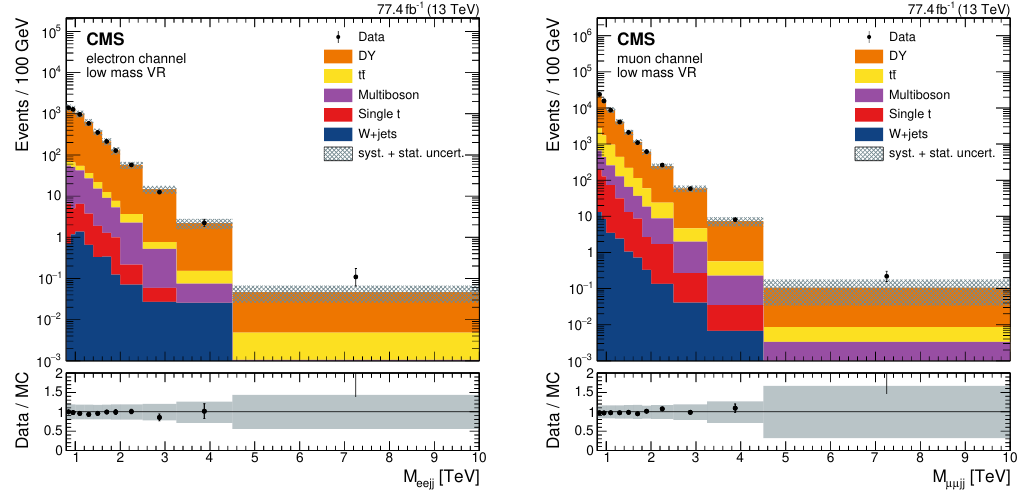
Figure 4 . Event distributions as a function of the four-body invariant M (left) and muon (right) channels, for the low-mass validation region de(cid:12)ned by M The lower panels show the ratio of data to the simulated SM background, with the shaded band representing the